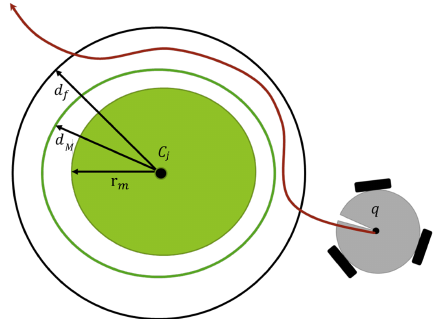
Figure 6. Obstacle avoidance task.